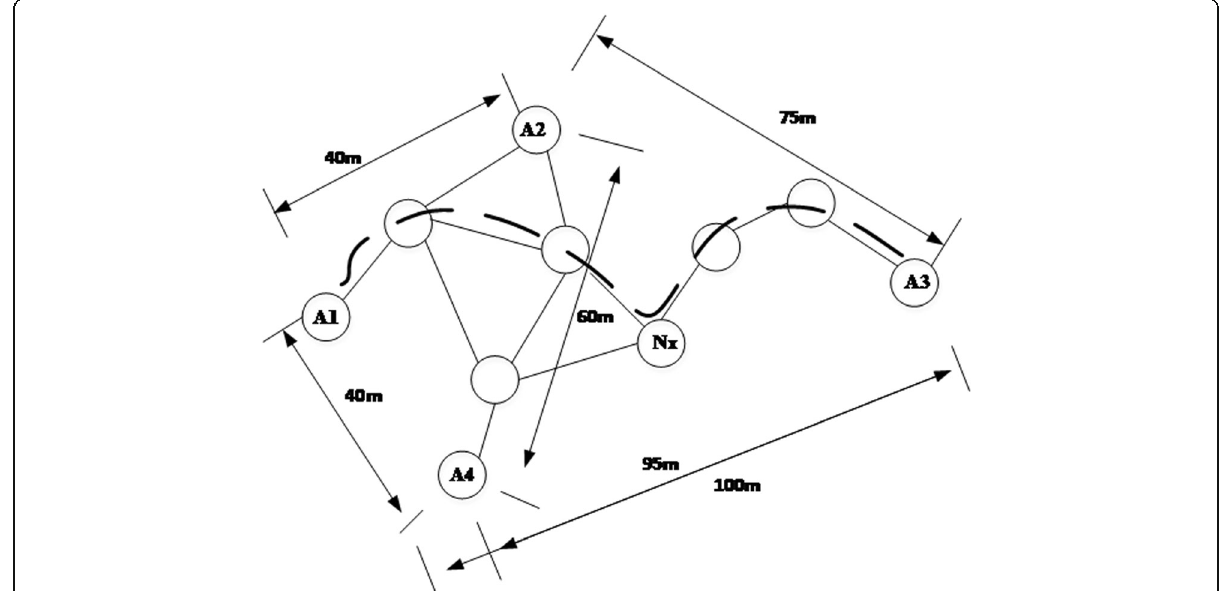
Fig. 1 The original DV-hop